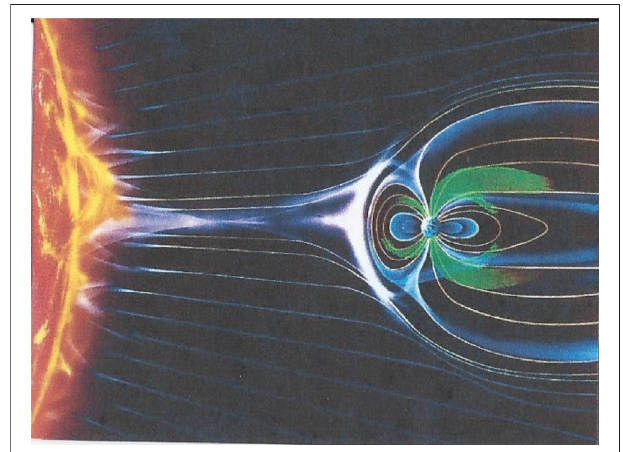
FIGURE 1 | A sketch of the solar-terrestrial connection that includes the contribution of the Earth ’ s ionosphere to the magnetosphere.